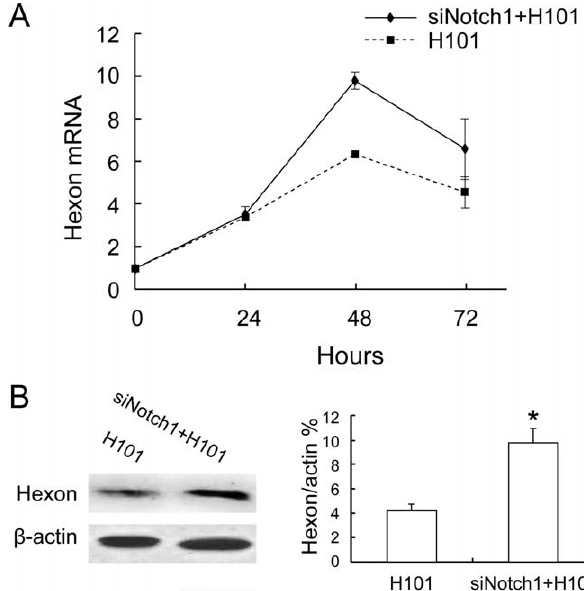
Figure 6. The effect of Notch1-siRNA on viral DNA replication in HeLa-S3 cells. A. Viral DNA replication was determined by real-time RT-PCR quantification of adenoviral late Hexon gene expression at 24, 48, and 72 hours after co-treatment, respectively. For comparison, the mRNA expression of Hexon at 24 hours in H101 group was arbitrarily set as 1, and b -actin was used as the internal control in the calculation. P , 0.05: compared to Hexon mRNA expression of the H101 group. B. Western blot analysis of Hexon protein at 72 hours. Bar: average band density of quantified Hexon protein after normalization by the internal control b -actin. Protein expression of Hexon in H101 group was arbitrarily set as 1. *P , 0.05: relative to Hexon protein expression in the H101-treated group. lines that had different status of p53 mutations, including lung cancer cells (A549) and uveal melanoma cells (OCM1 and VUP). Both OCM1 and VUP cell lines contain a common mutation (C.